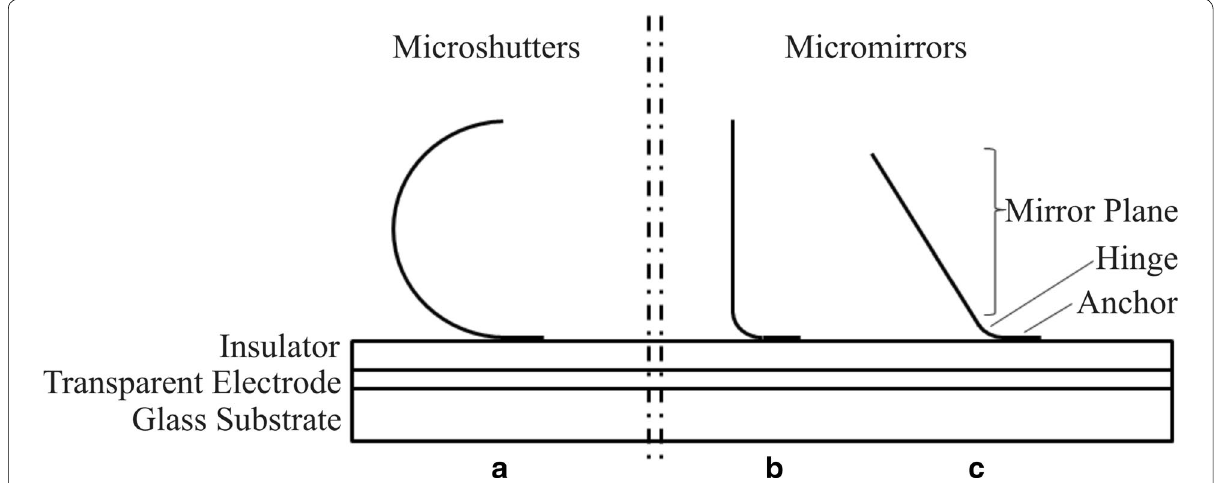
Fig. 1 Cross section of microshutters in opened state ( a ), micromirrors in opened non-actuated state ( b ), and in an intermediate state during actuation ( c